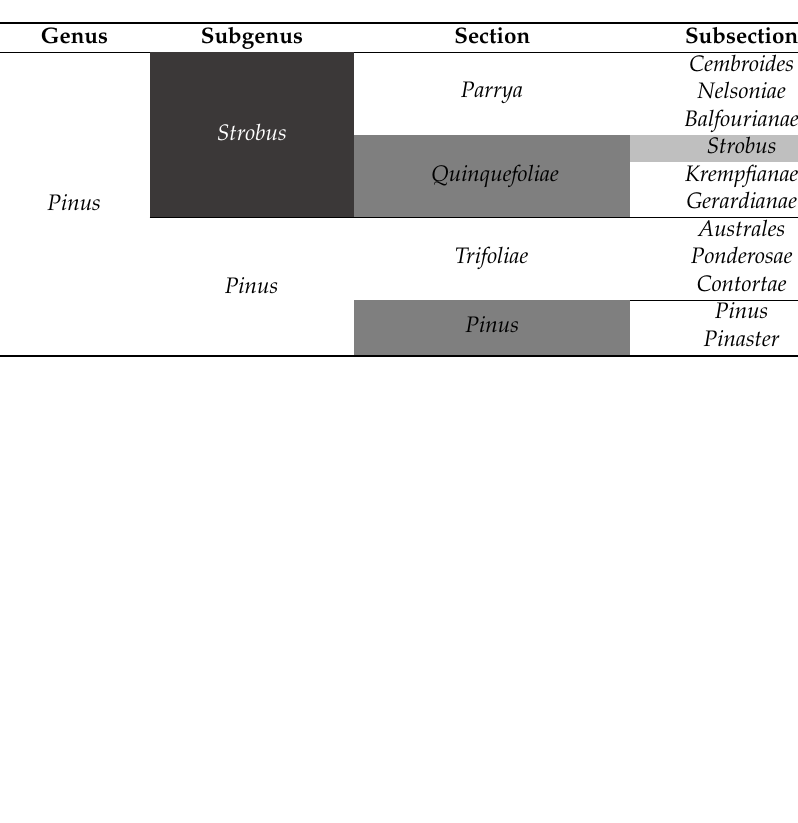
Table 2. Classification system for the genus Pinus . The classification system is based on Gernandt et al. [24]. The colors indicating various taxa correspond to those in Table